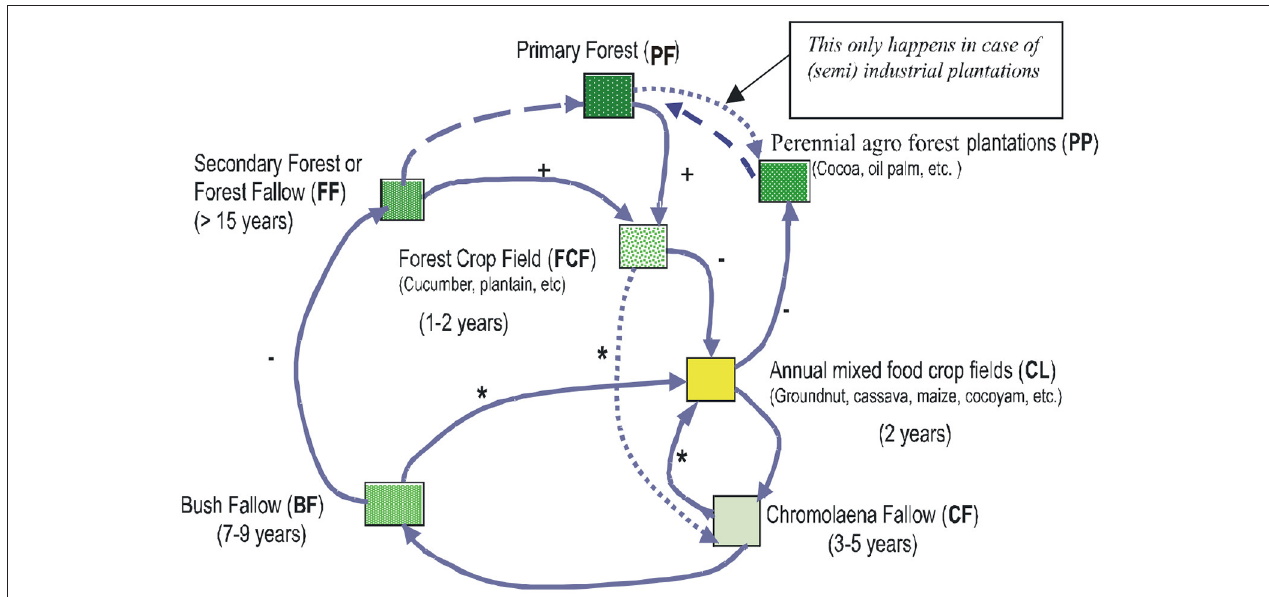
FIGURE 2 | Observed transitions between land uses. Adapted from Yemefack (2005, Chapter 2). ( ) Common transitions; ( ) Infrequent transitions; ( ) PF recovery after definite abandonment; ( + ) patches can split (fragmentation); (–) patches can merge with others of the same type (consolidation); (*) patches can merge with those of other